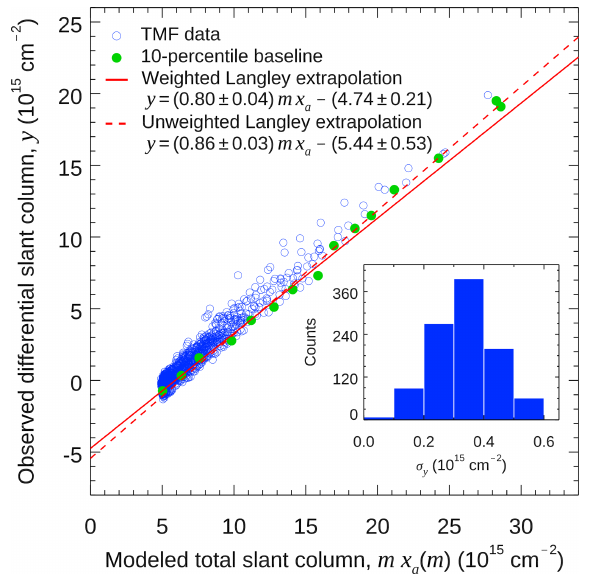
Figure 3. The modified minimum-amount Langley extrapolation (MMLE). The blue circles are the observed differential slant columns during our campaign over TMF from 23 to 28 October 2018. Each observational value is plotted against the total slant column modeled at the same time of the day (e.g., 11:05PST). The green dots are the 10th percentile of 20 uniform bins on the x axis. The red line is a linear regression of the green dots, which is taken as the background diurnal cycle in a clean at- mosphere. The linear fit weighted by the number of data points in the bins is y = 0 . 80 mx a (m) − 4 . 74 × 10 15 . The 2 σ uncertain- ties of the slope and the intercept are 0 . 04 and 0 . 21 × 10 15 , re- spectively. The y intercept thus gives a reference column, y 0 = 4 . 74 × 10 15 moleculescm − 2 . The unweighted linear fit overesti- mates the reference column (544 × 10 15 moleculescm − 2 ) because of the sparse data points at air mass factors greater than ∼ 2. Thus, the weighted linear fit is used as the Langley extrapolation in this work. The inset shows the distribution of the 2 σ uncertainty of the observed differential slant